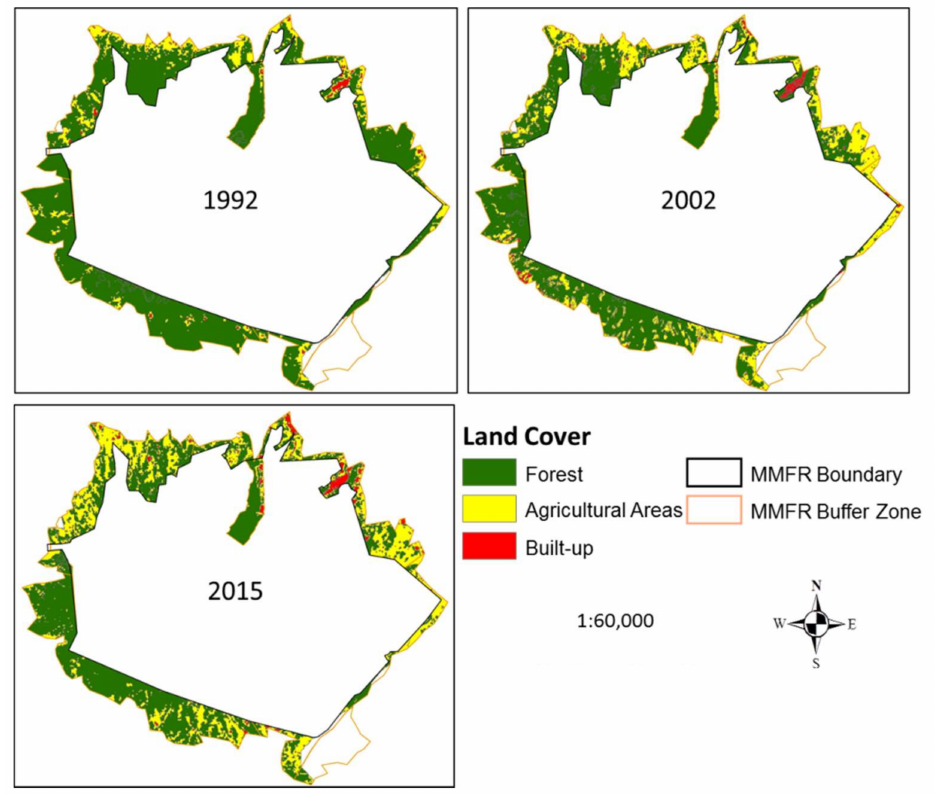
Figure 5. Land Cover Maps of MMFR Buffer Zone in 1992, 2002 and 2015 generated using the Supervised Classification